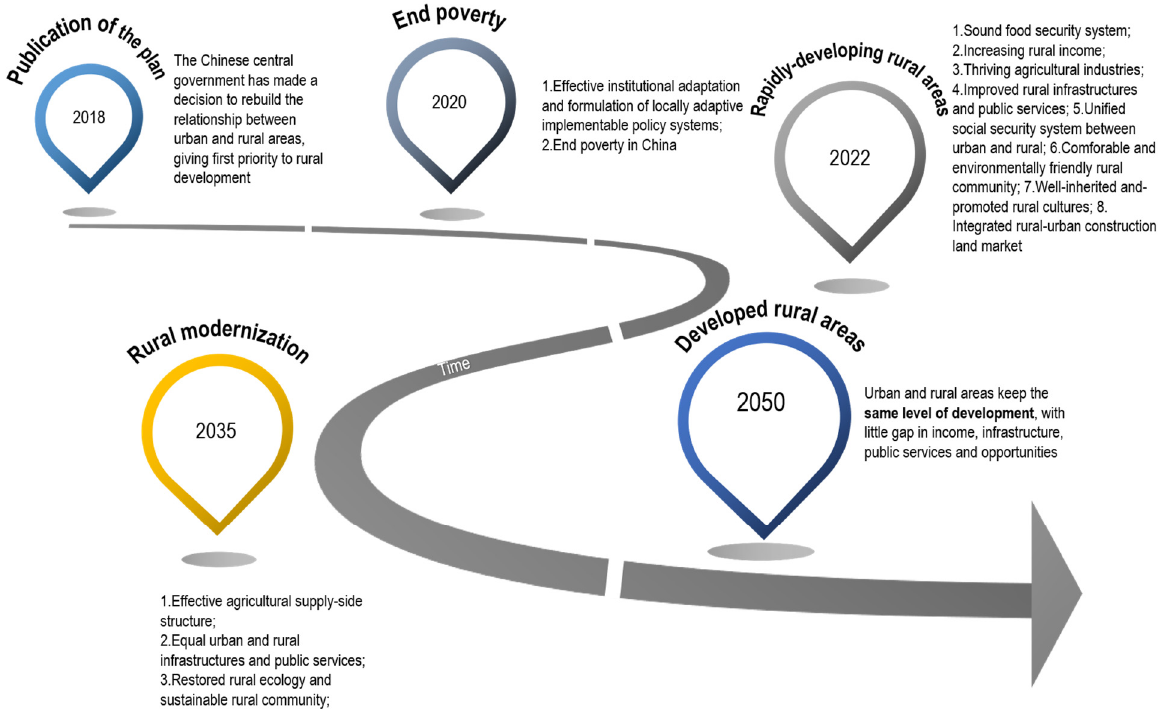
Figure 3. Milestones and goals of China’s rural development strategy. © authors (Source: State Council